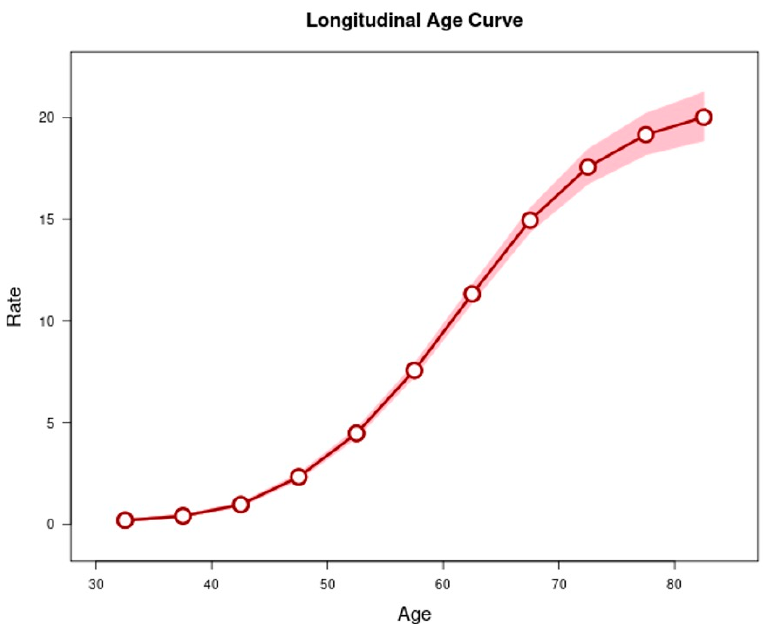
Figure 2. Longitudinal age curves of esophageal cancer in SEER 12 from 1992 to 2019 and corresponding 95% confidence intervals.